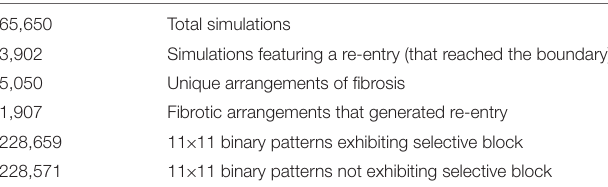
TABLE 2 | Summary of the simulations performed, and the resulting data used for machine learning (ML) (using one structure size as an example).